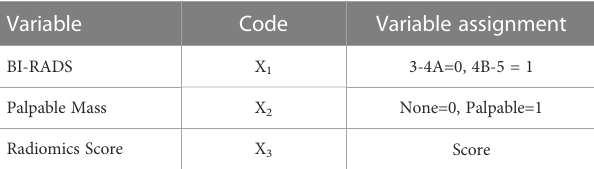
TABLE 3 Variable assignment table in the logistic regression